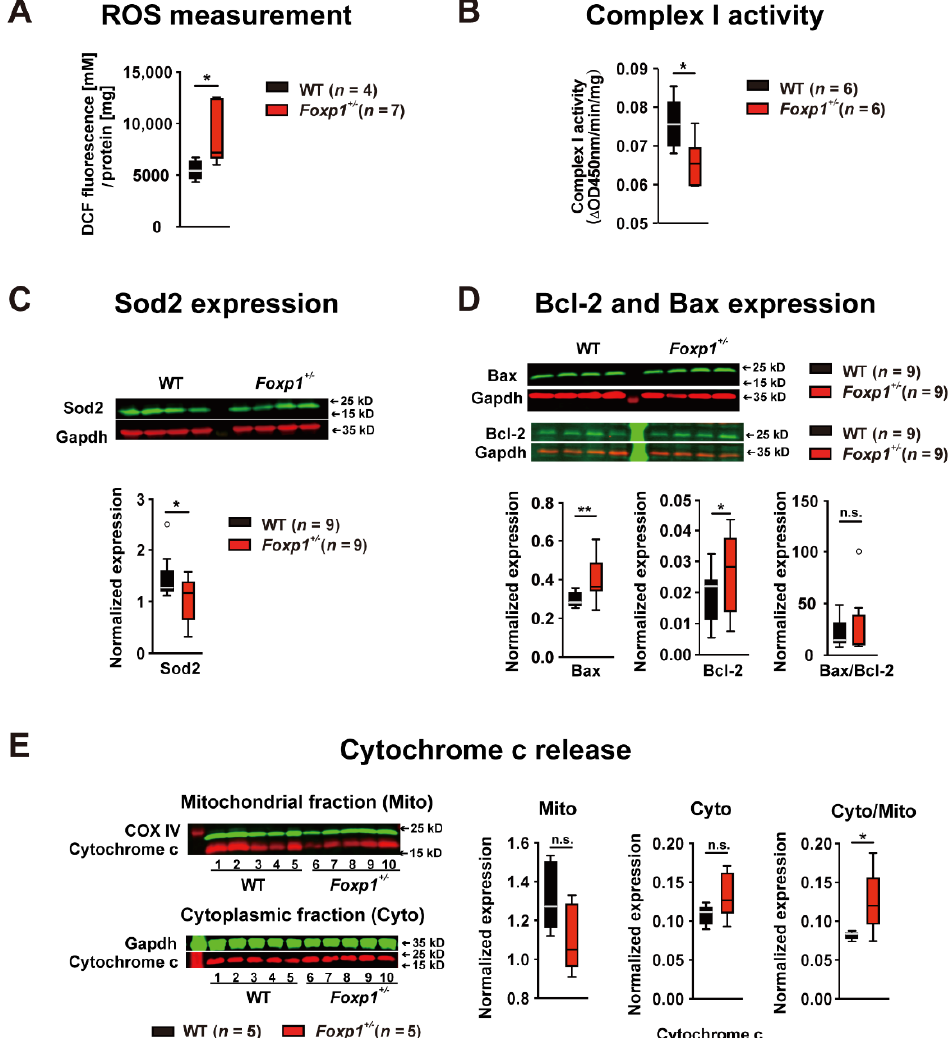
Figure 4. Adult Foxp1 +/− mice show increased oxidative stress and pre-apoptosis in the hippocampus. ( A ) Abundance of ROS as quantified by DCF staining. Increased ROS by ~67% in the Foxp1 +/− hippocampus indicates elevated oxidative stress. ( B ) Complex I enzyme activity as determined with the Microplate Assay Kit (Abcam). Complex I activity was decreased by ~14% in Foxp1 +/− tissue compared to WT. ( C ) Antioxidant enzyme Sod2 was quantified by western blot and showed a ~29% reduced expression in the Foxp1 +/− hippocampus. ( D ) Bax and Bcl-2, two markers of pre-apoptosis, were increased by ~71% and ~38% in Foxp1 +/− tissue, whereas the Bax/Bcl-2 ratio did not differ between genotypes. ( E ) The release of cytochrome c induced by certain pro-apoptotic stimuli was tested in WT and Foxp1 +/− tissues by quantifying the protein in mitochondrial and cytosolic fractions by western blot. A ~52% increased ratio of cytosolic to mitochondrial cytochrome c compared with WT indicates increased cytochrome c release in the Foxp1 +/− hippocampus. The exact number of animals tested per group is indicated in the figure. Weak outliers are marked with a circle. Asterisks indicate a significant difference (* p ≤ 0.05, ** p ≤ 0.01); n.s. indicates non-significant; two-way ANOVA.